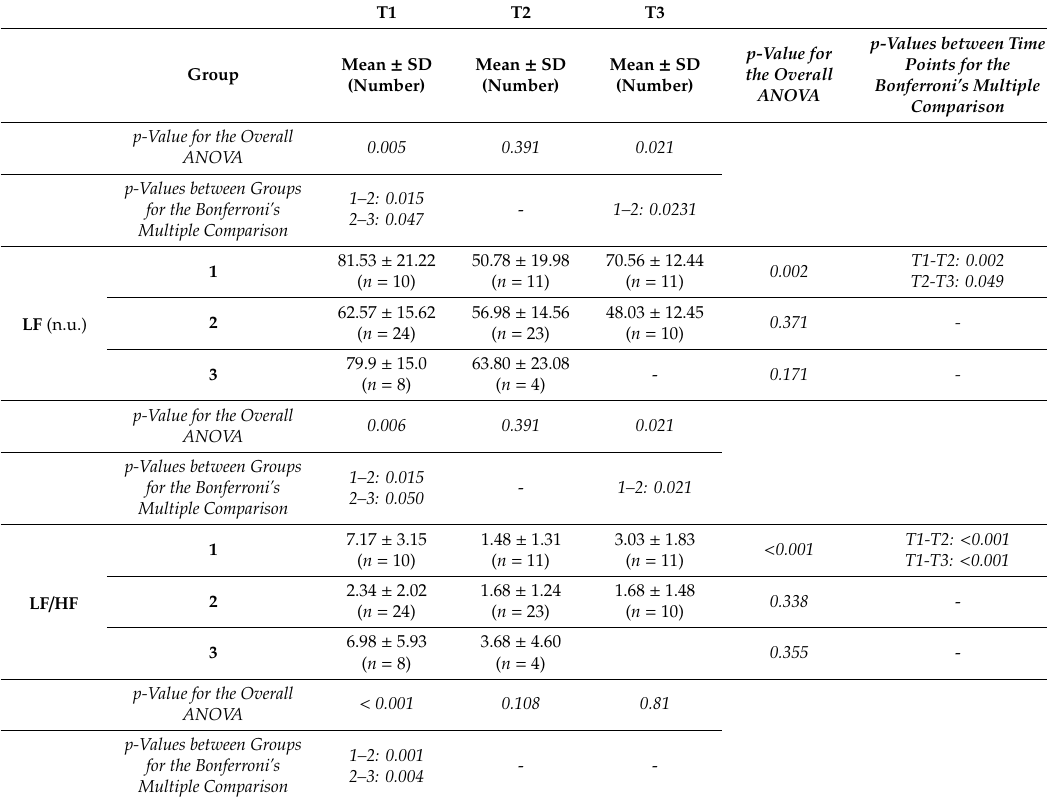
Table 4. Laboratory variables at the three measurements time points (T1, T2, and T3) and in the three treatment groups.